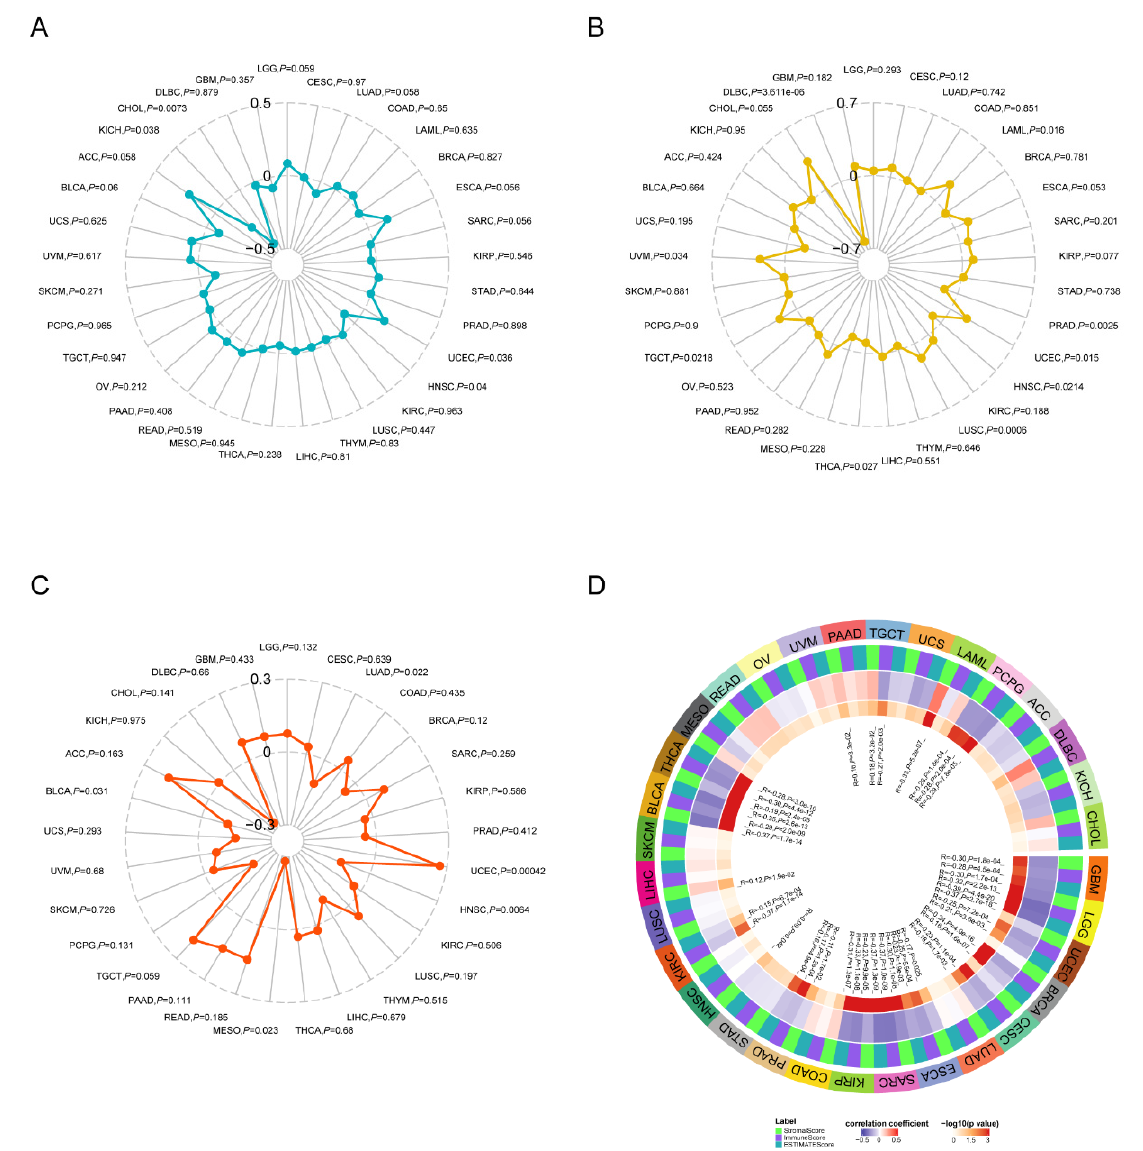
Figure 5. The relationship between ZDHHC7 expression and tumor mutational burden (TMB) ( A ), microsatellite instability (MSI) ( B ), neoantigen ( C ) and ESTIMATE score ( D ) in human cancers. ACC, adrenocortical carcinoma; BLCA, bladder urothelial carcinoma; BRCA, breast invasive carcinoma; CESC, cervical squamous cell carcinoma and endocervical adenocarcinoma; CHOL, cholangiocarcinoma; CESC, cervical squamous cell carcinoma; COAD, colon adenocarcinoma; ESCA, esophageal carcinoma; GBM, glioblastoma multiforme; HNSC, head and neck squamous cell carcinoma; KICH, kidney chromophobe; KIRC, kidney renal clear cell carcinoma; KIRP, kidney renal papillary cell carcinoma; LAML, acute myeloid leukemia; LGG, brain lower grade glioma; LIHC, liver hepatocellular carcinoma; LUAD, lung adenocarcinoma; LUSC, lung squamous cell carcinoma; MESO, mesothelioma; OV, ovarian serous cystadenocarcinoma; PAAD, pancreatic adenocarcinoma; PCPG, pheochromocytoma and paraganglioma; PRAD, prostate adenocarcinoma; READ, rectum adenocarcinoma; SARC, sarcoma; SKCM, skin cutaneous melanoma; STAD, stomach adenocarcinoma; TGCT, testicular germ cell tumors; THCA, thyroid carcinoma; THYM, thymoma; UCEC, uterine corpus endometrioid carcinoma; UCS, uterine carcinosarcoma; UVM, uveal melanoma.